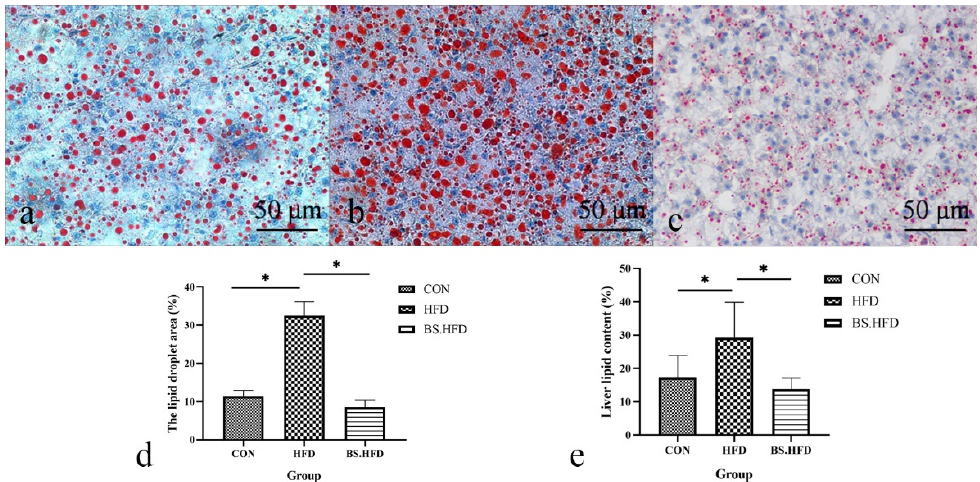
Figure 1. Oil red O staining and lipid content of C. idella liver; ( a ) CON, ( b ) HFD, ( c ) BS.HFD, ( d ) lipid droplet area proportion, ( e ) liver lipid content determined by Soxlet extraction. “*” means significant differences between groups ( p < 0.05).